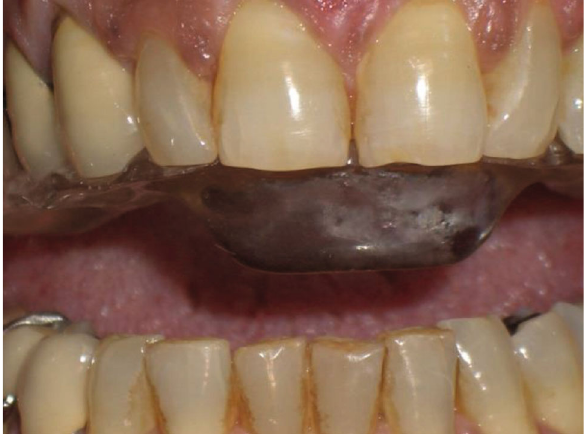
Figure 5: Pivot mandibular advancement.